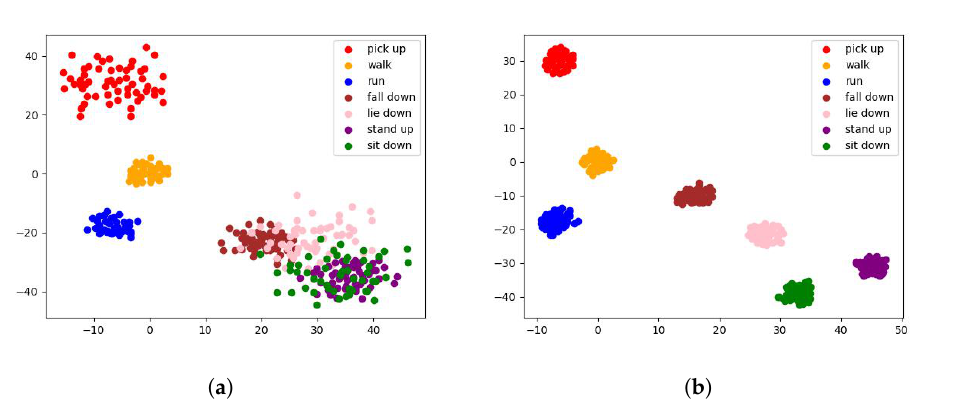
Figure 7. Classification performance. ( a ) Model performance without Convolution module and Gaussian prior. ( b ) Model performance with Convolution module and Gaussian prior.